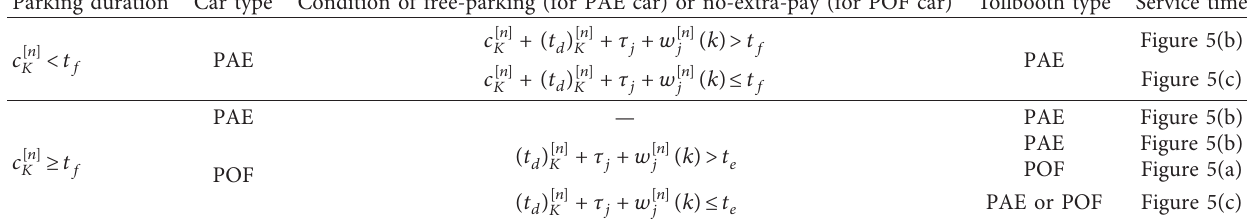
Table 1: Service times in all possible scenarios.